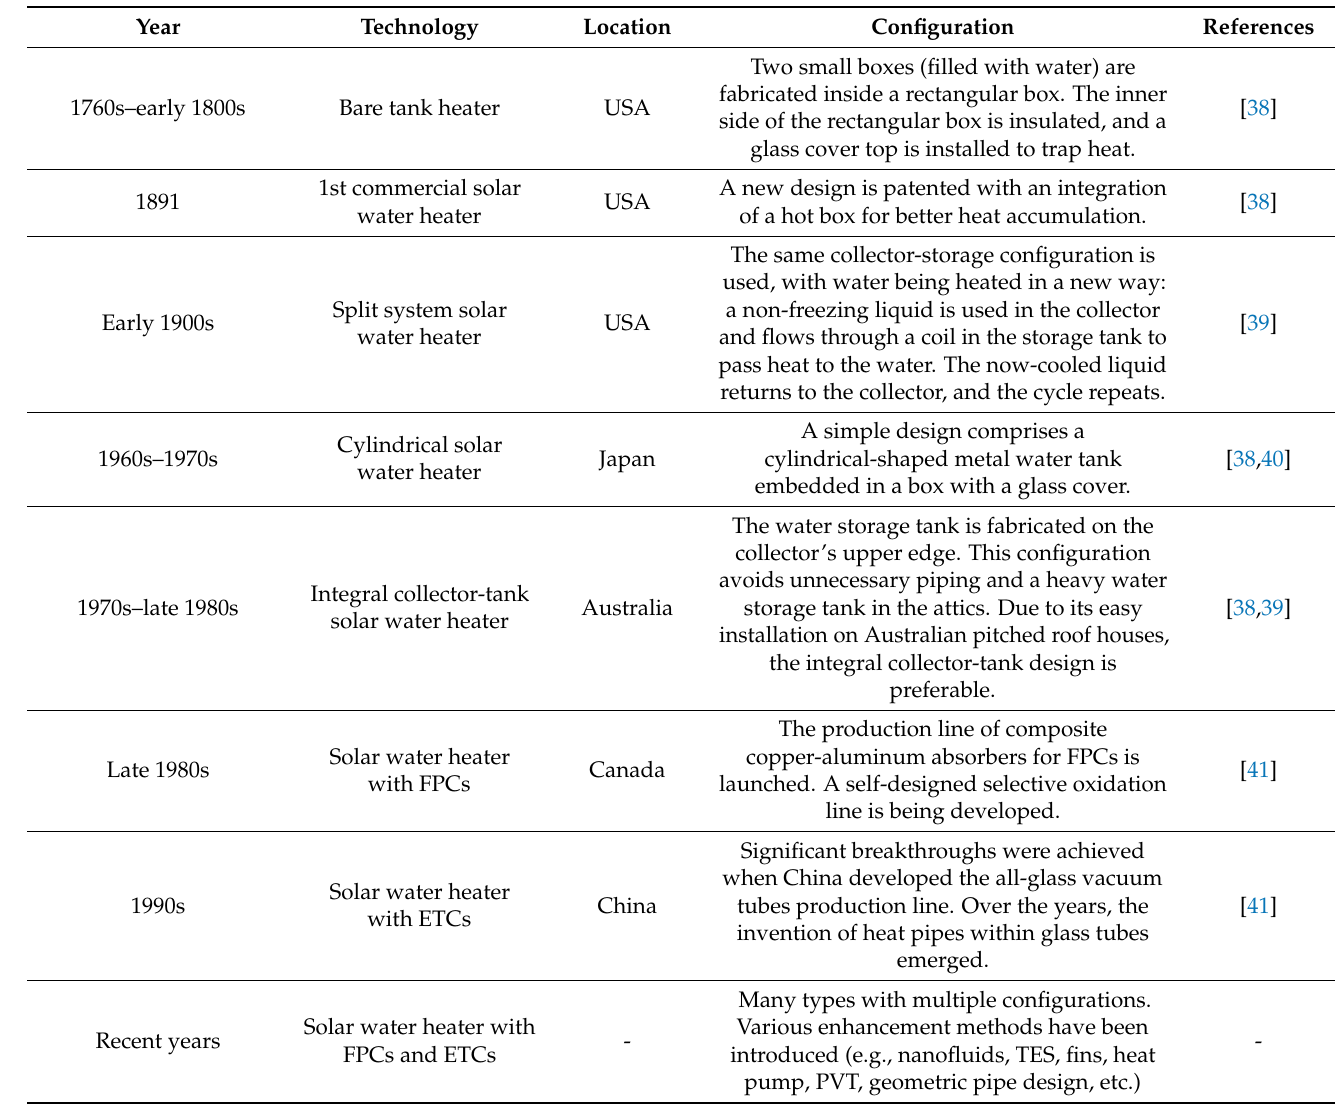
Table 2. The global evolution of SWH